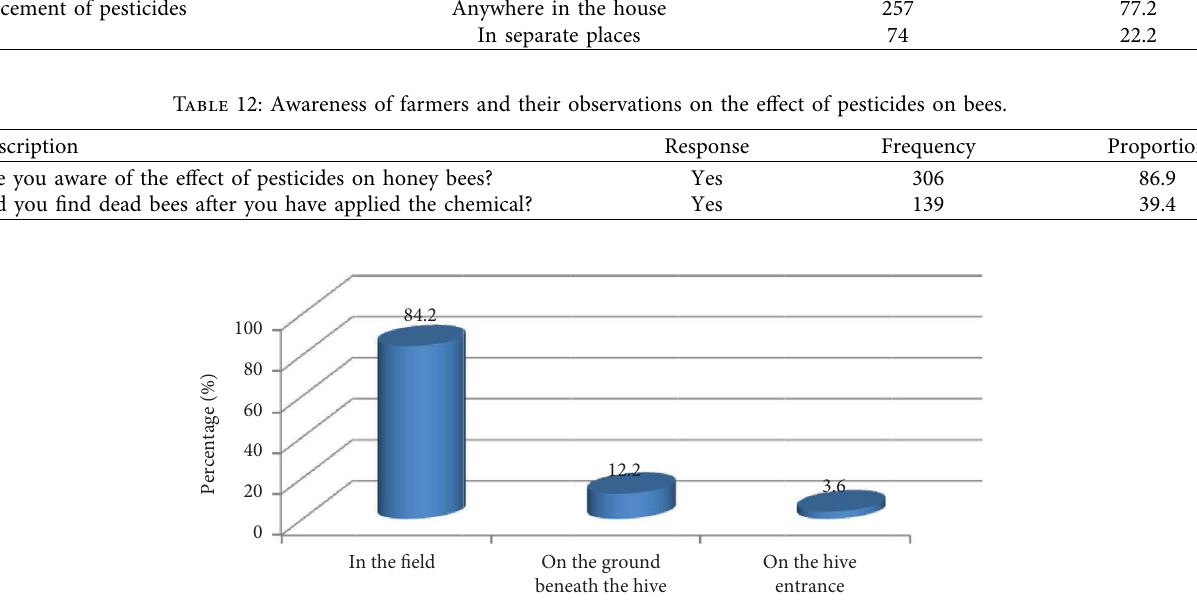
Figure 5: Proportion of the respondents who have found dead bees at diferent